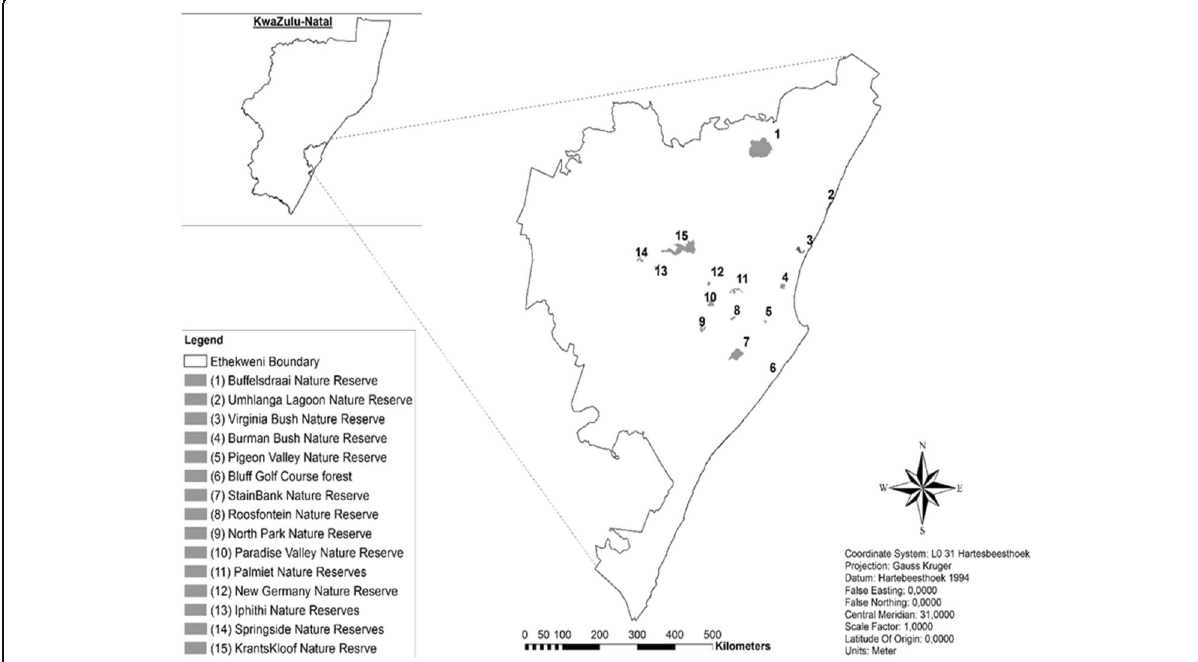
Fig. 1 Map of the study area (eThekwini Municipality) in KwaZulu-Natal, South Africa, indicating the 15 study